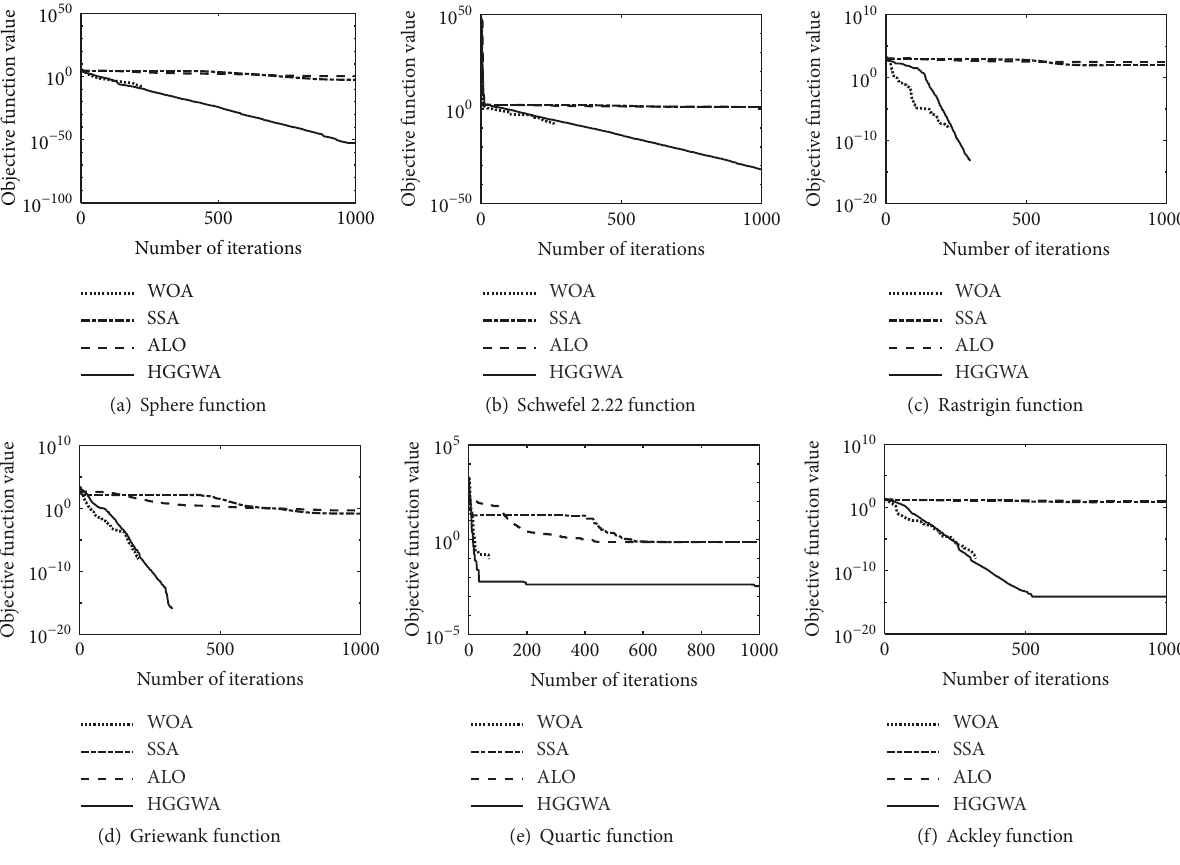
Figure 2: Convergence curves of WOA, SSA, ALO, and HGGWA algorithms.